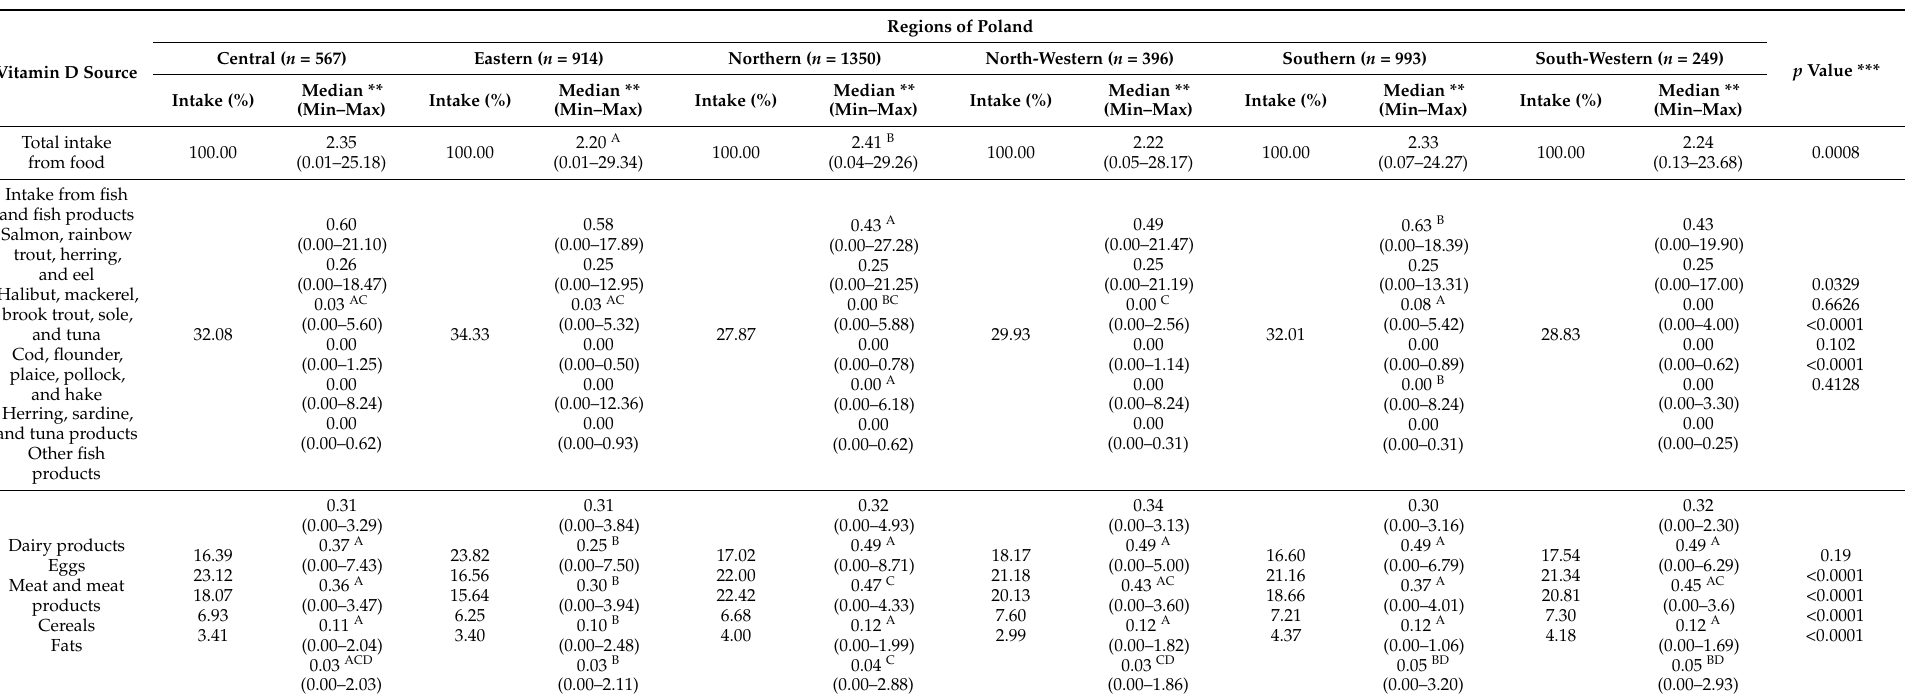
Table 4. Comparison of vitamin D intake from various food groups ( µ g per day) in the subgroups of female post-primary school students from different regions of